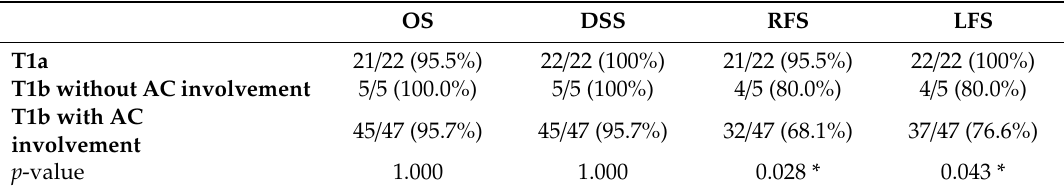
Table 3. Survival outcomes.